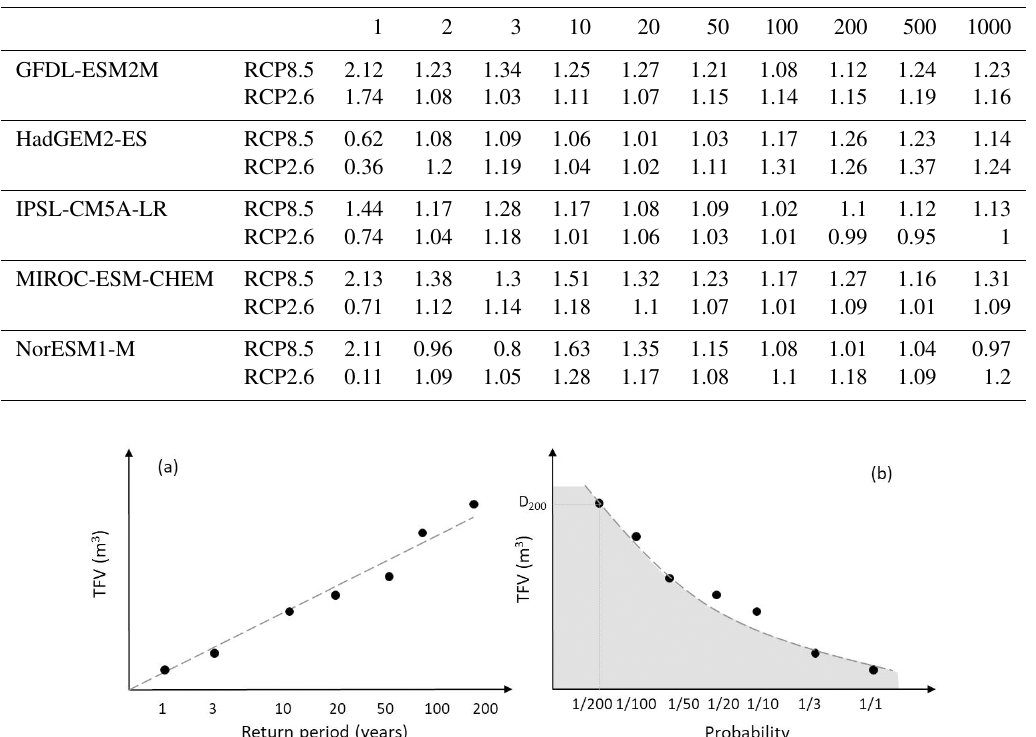
Figure 2. Illustration of total flood volume (TFV) as a function of return periods (a) and estimation of average total expected TFV per year (i.e. the grey area in b) under a stationary drainage